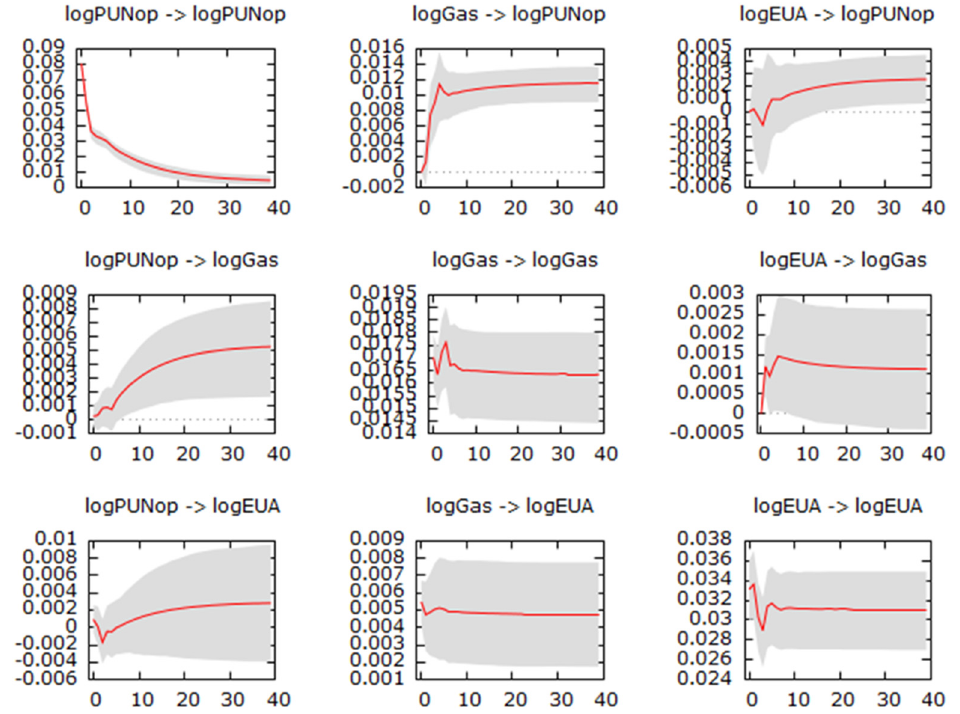
Figure A3. Impulse response functions of the VECM model (three variables, off-peak PUN, one cointegration relation). The shaded area represents the 90% confidence interval.